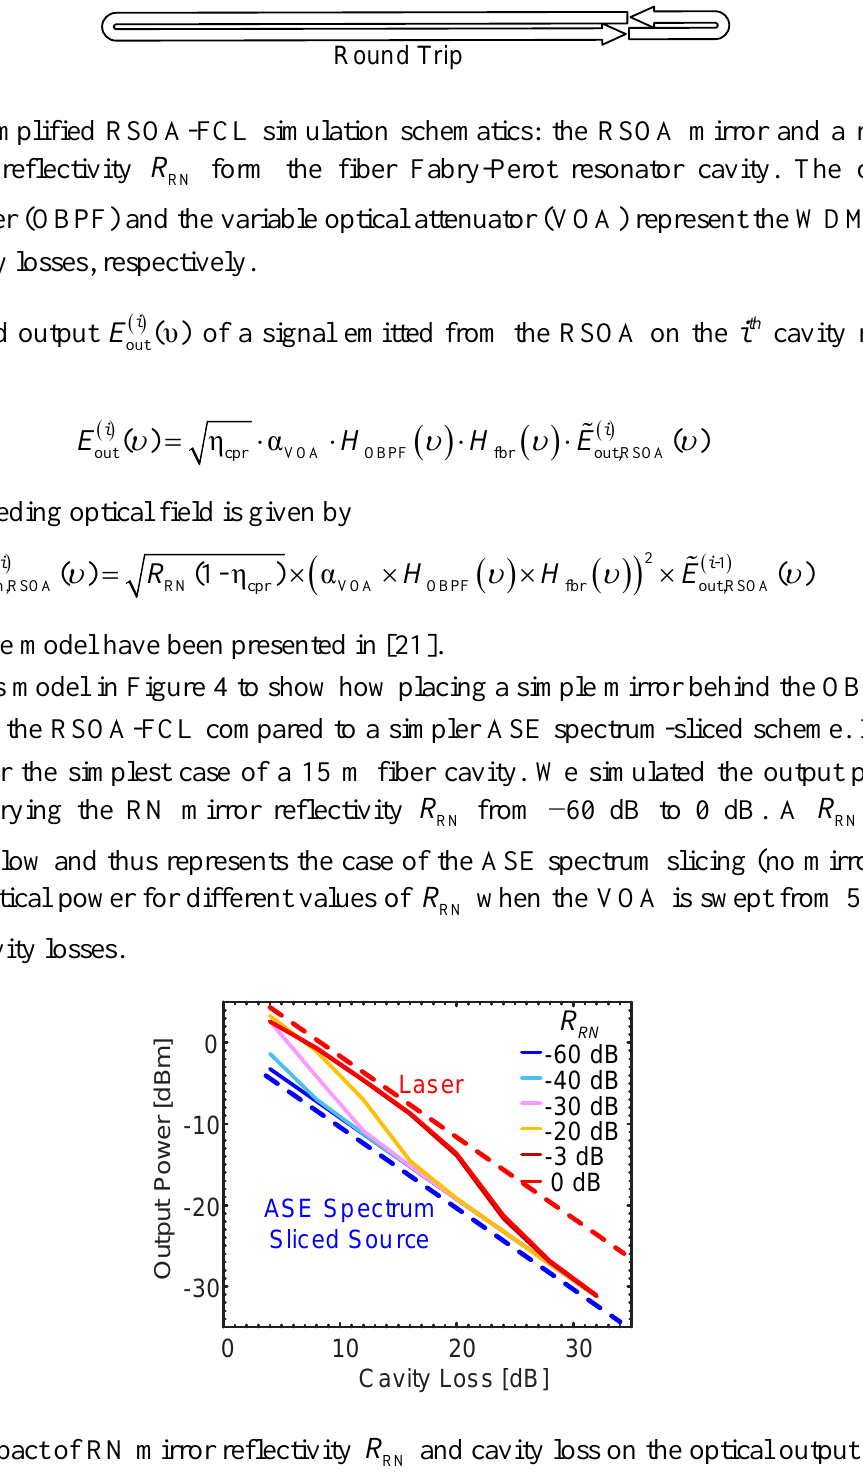
Figure 5. Impact of RN mirror reflectivity of the RSOA-FCL. Depending on the spectrum-sliced source (dashed blue line) or a RSOA-FCL laser (dashed red